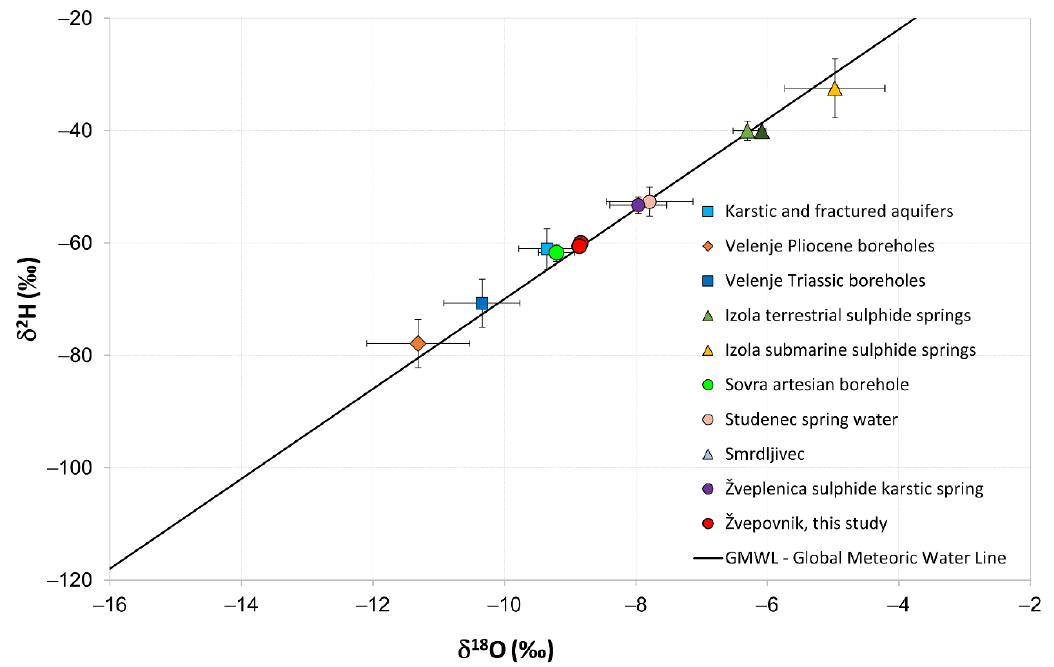
Figure 6. The δ 2 H versus δ 18 O values of the Žvepovnik spring shown relative to the global meteoric water line (GMWL; δ 2 H = 8 × δ 18 O + 10; [60]) and compared to other Slovenian springs such as the Žveplenica sulphur karstic spring [8], the Sovra artesian borehole [7], the Studenec spring water [7], the Izola submarine and terrestrial sulphur springs [9], and the Smrdljivec spring [10], as well as to groundwater from karstic and fractured aquifers in central Slovenia [62] and Pliocene and Triassic boreholes from the Velenje area [63].